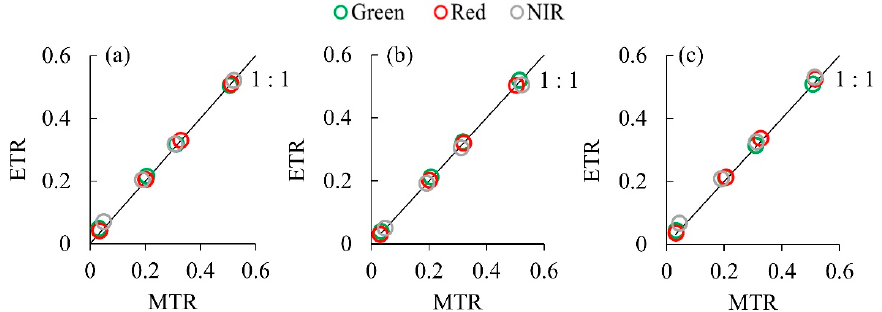
Figure 7. Comparisons of the estimated tarp reflectances (ETR) and measured tarp reflectances (MTR) using the RAV RSS for green (560 nm), red (660 nm), and NIR (830 nm) under different light intensities of ( a ) 1179 μ mol at the National Institute of Crop Science (NICS) and ( b ) 1100 μ mol and ( c ) 1230 μ mol at Chonnam National University (CNU). Four reference tarps with reflectances of 3.1%, 21%, 32%, and 51% were used.